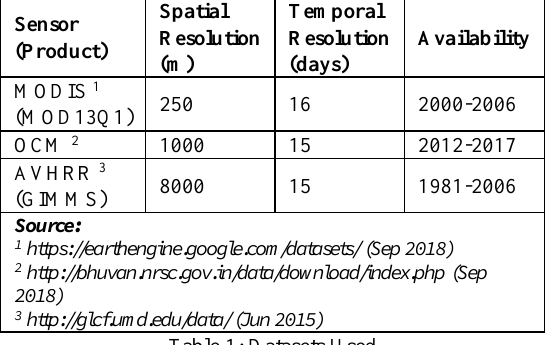
Three sensor products were used in this study as provided in Table 1. Normalised Difference Vegetation Index (NDVI) derived from the MODIS instrument data, on-board the Terra satellite, was used to perform the analysis from February 2000 till December 2006 (16 day temporal resolution). A purpose- specific Javascript code written on the Google Earth Engine platform was used to download the required data (in space and time).